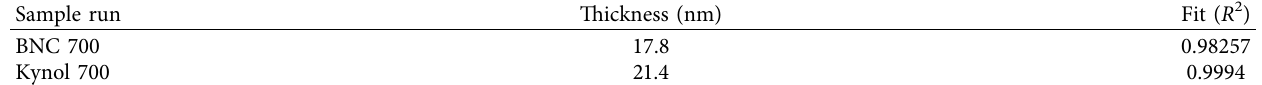
2 coating by ALD, in (c) Kynol